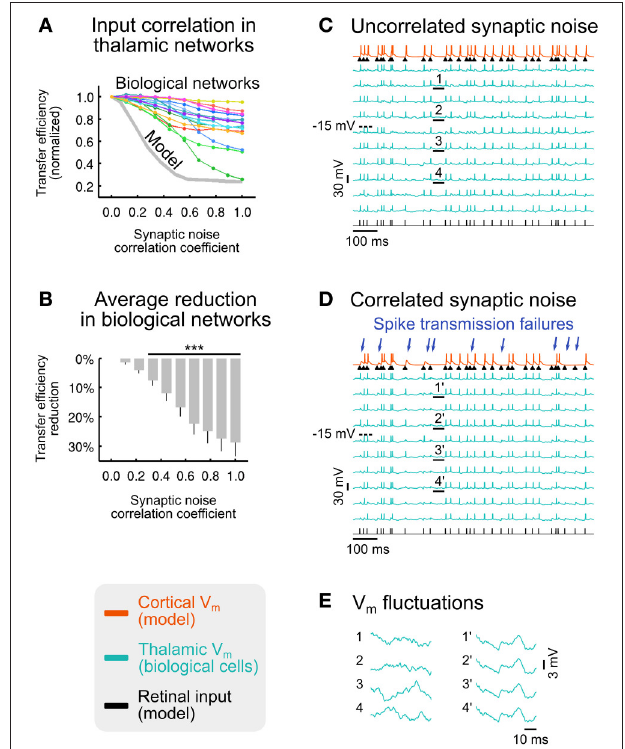
FIGURE 7 | Effect of synaptic noise correlation across TC cells on sensory information transfer. (A) Normalized transfer efficiency in model (gray curve) and biological networks (colored curves) for increasing levels of synaptic noise correlation across thalamic neurons. (B) Average transfer efficiency reduction ( ± SEM) across all biological networks shown in (A) ( *** p < 3.10 − 4 ; t -test; n = 15 ). (C) Illustration of voltage traces for a biological network receiving uncorrelated synaptic bombardment. (D) Same biological network as in (C) receiving correlated synaptic bombardment. Retinal spikes that were detected by the recipient cortical neuron in (C) but not detected in (D) are indicated by blue arrows. (E) Zoomed sections of membrane potential fluctuations underlined in (C) (sections 1–4; uncorrelated synaptic bombardment) and (D) (sections 1’–4’; correlated synaptic bombardment). Modified from Béhuret et al.